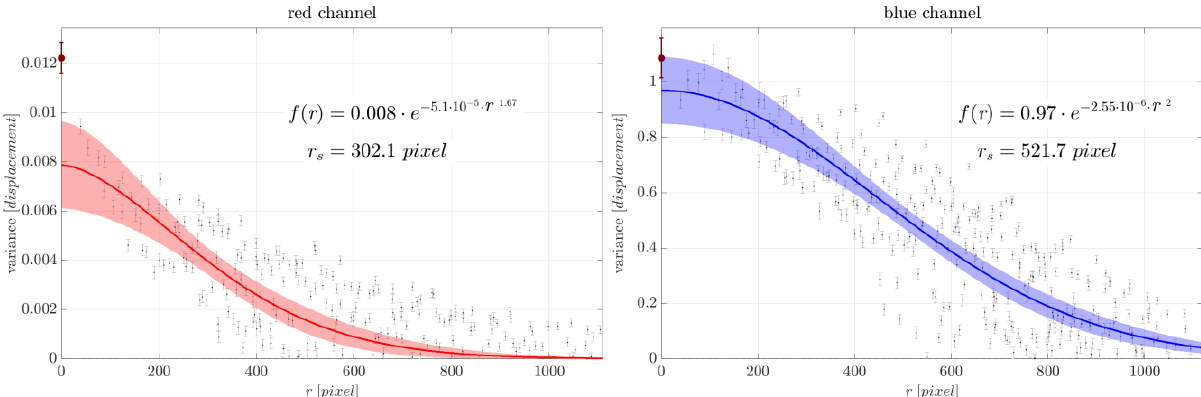
Figure 4. Correlation functions for red (left) and blue (right) channels fitted to the autocorrelation of the displacements. Grey points represent the average autocorrelation between equal distances (with a certain tolerance to gather roughly equal distances). Colored function envelopes show the 3𝜎 boundaries of the estimated parameters. Correlation lengths 𝑟 𝑠 are given in pixels. The brown point at 𝑟 = 0 indicates the total variance, i.e., 𝜎 𝑠2 + 𝜎 𝑛2 . Note the different scales on the ordinate axes.